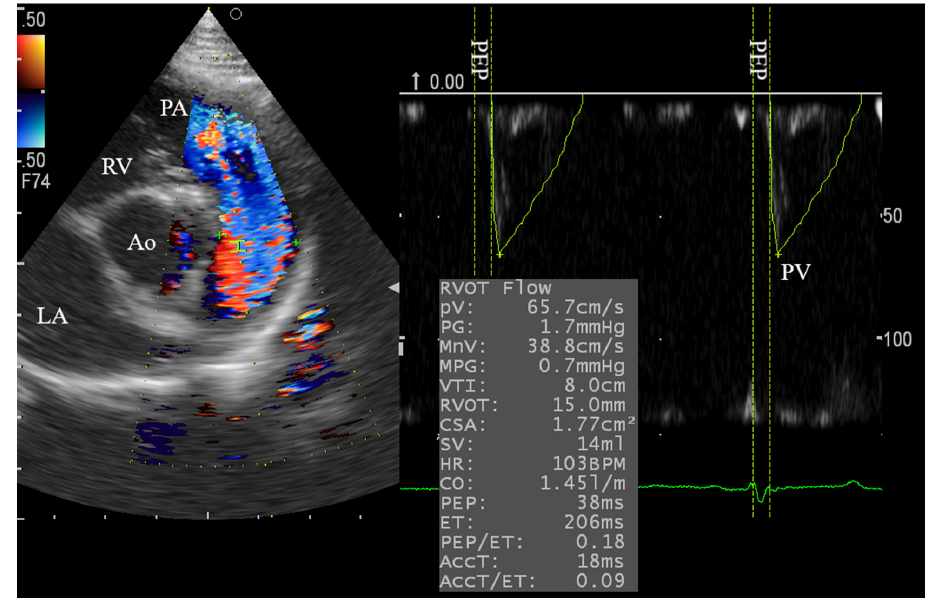
Figure 2. Pulsed-wave Doppler echocardiography for evaluation of the pulmonary blood flows in male goats through RPSAV at the level of the aortic valve and main pulmonary artery. The sample volume was adjusted at 2.0 mm. LA, left atrium; Ao, aorta; RV, right ventricle; PA, main pulmonary artery; PV, peak velocity; PEP, pre-ejection